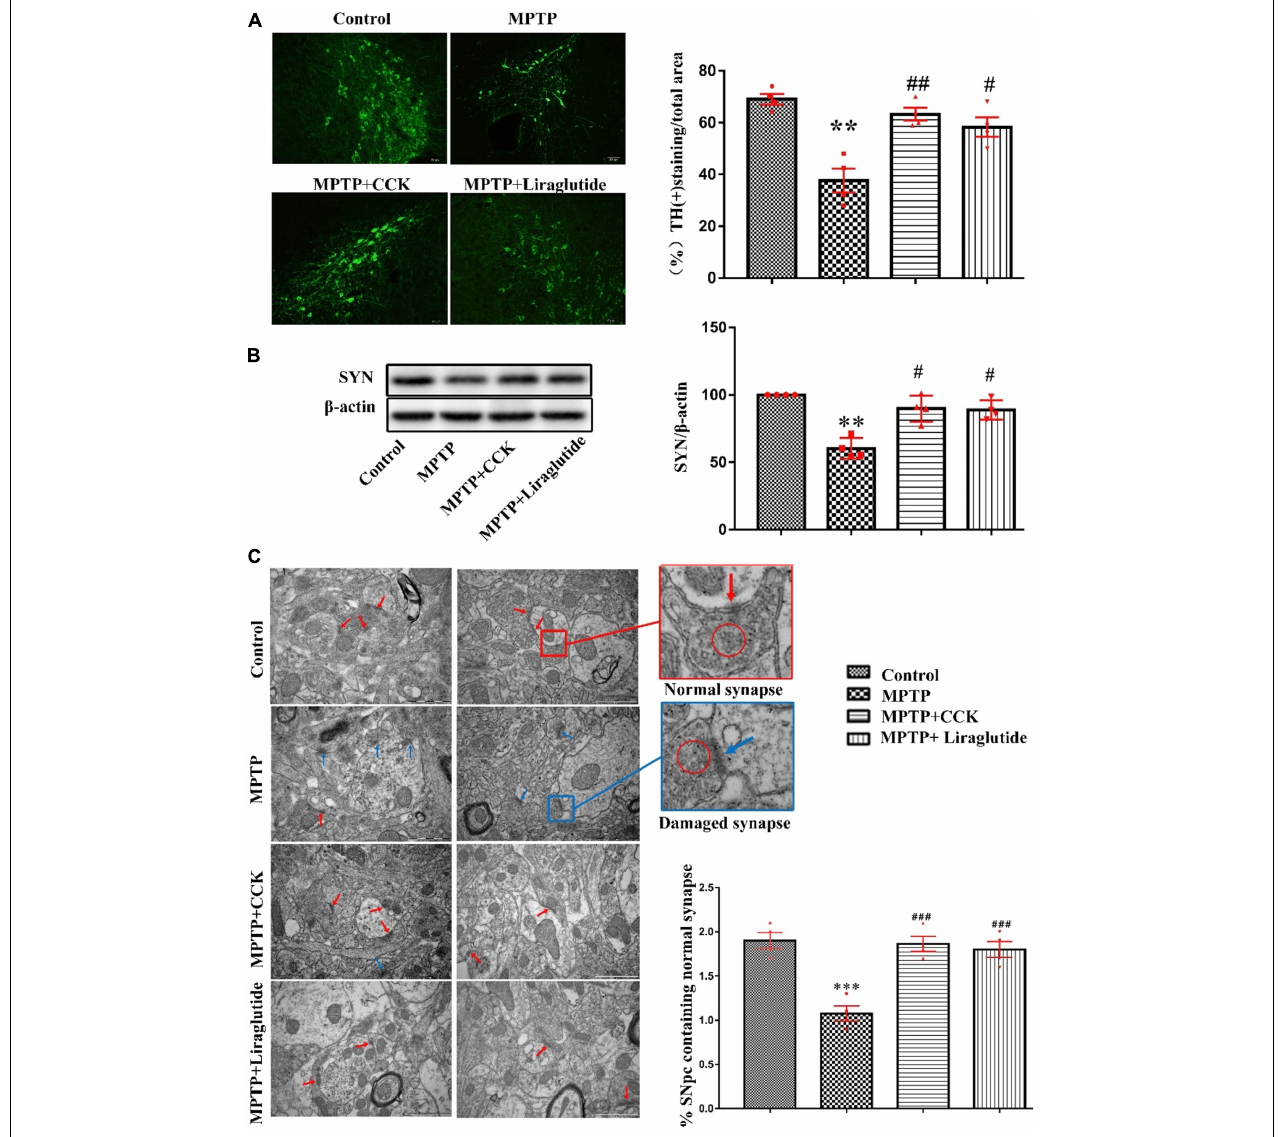
FIGURE 3 | Liraglutide and the CCK analogue reversed dopaminergic neurons and synapse damage induced by MPTP. (A) The average area of TH-positive neurons in the SNpc of mice in each group (Scale bar: 50 µ m). (B) Western blot showing the protein levels of SYN and actin as a loading control for each group. (C) TEM observation of synapse in the SNpc of mice in each group. Individual synapse were identified by the presence of at least three presynaptic vesicles (red circle) and an identifiable synaptic gap (normal synapse: red arrows and damaged synapse: blue arrows) (Scale bar: 1 µ m). ∗∗ P < 0.01, ∗∗∗ P < 0.001, compared with the